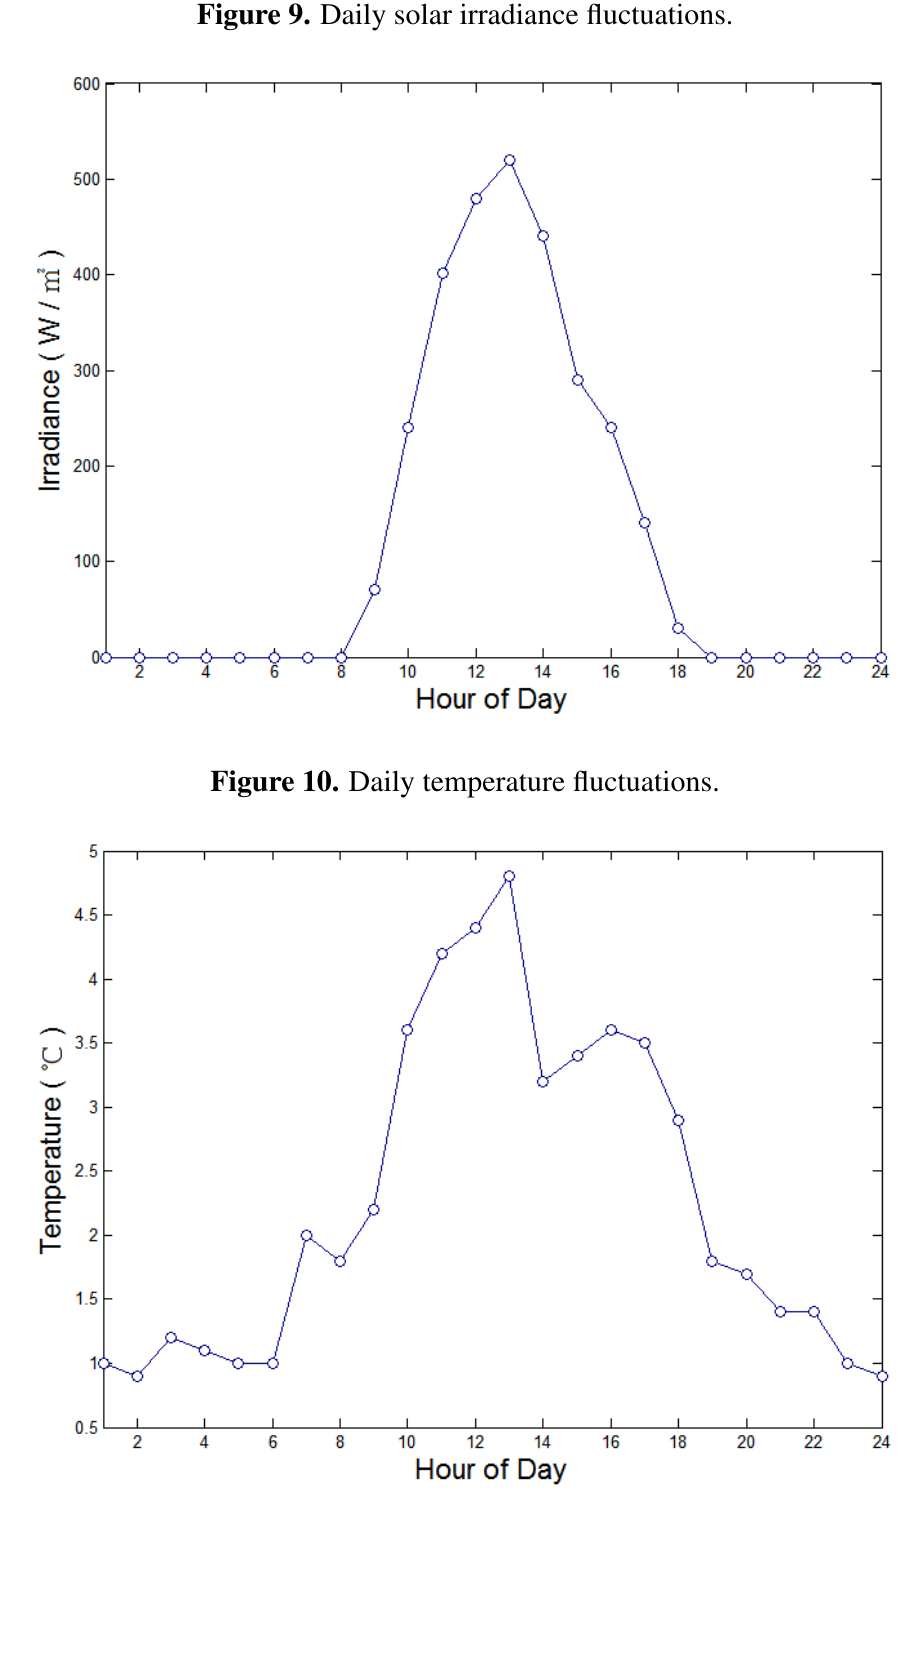
Figure 9. Daily solar irradiance fluctuations.